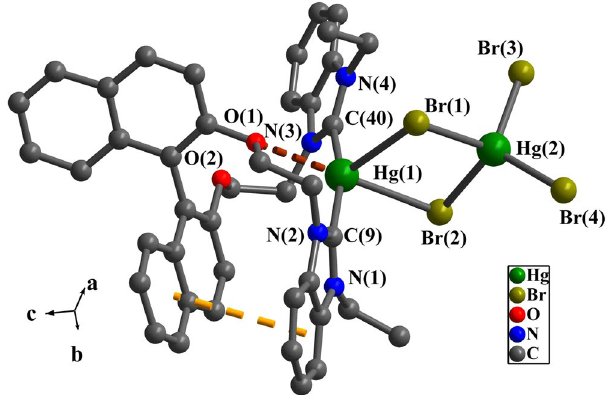
Figure 4. Perspective view of 1 . All hydrogen atoms were omitted for clarity. Selected bond lengths (Å) and angles (°): Hg(1)-Br(1) 3.037(1), Hg(1)-Br(2) 2.988(1), Hg(1)-C(9) 2.093(1), Hg(1)-C(40) 2.091(1), Hg(2)-Br(1)